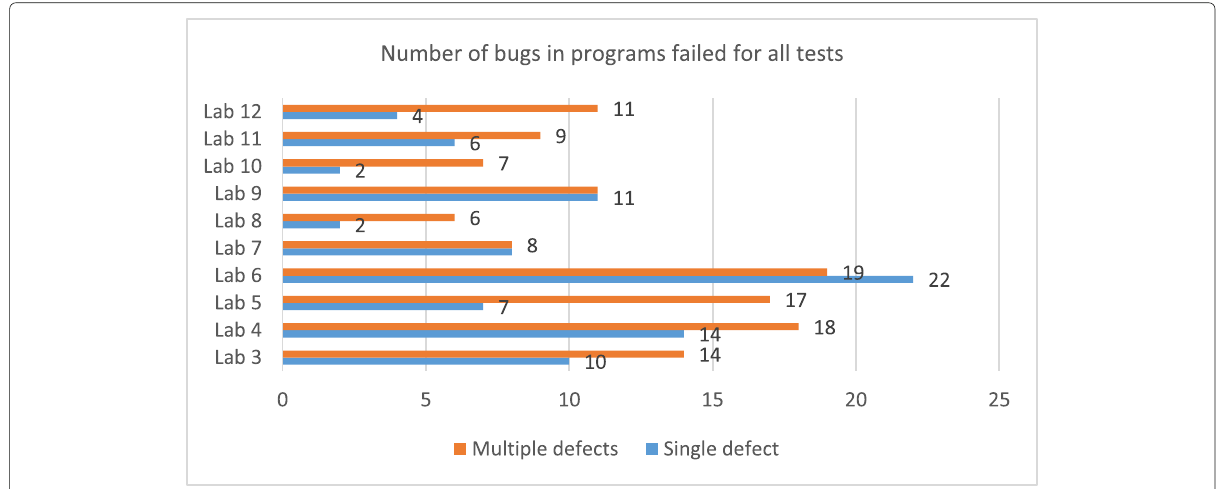
Fig. 4 Number of bugs in programs failed for all the given test cases in the test